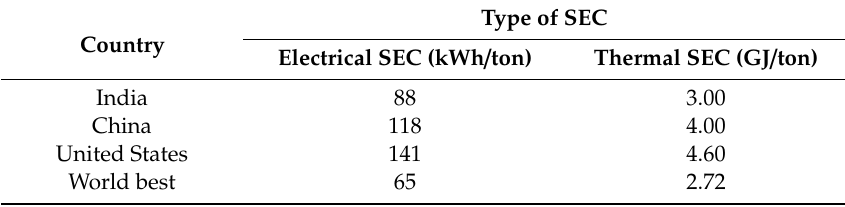
Table 2. Comparison of electrical and thermal specific energy consumption (SEC) for few selected countries around the world